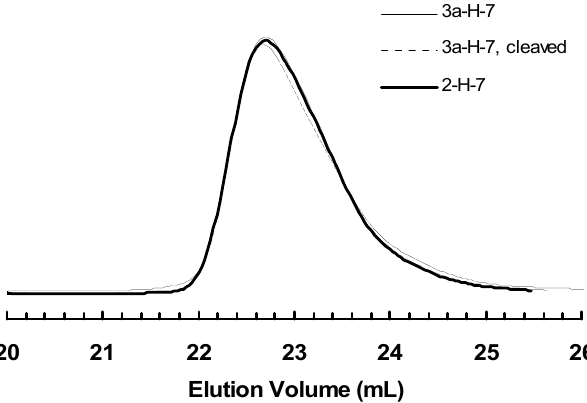
Figure 12. GPC elution curve of cleaved sample 3a-H-7, in comparison with those of 3a-H-7 and 2-H-7.